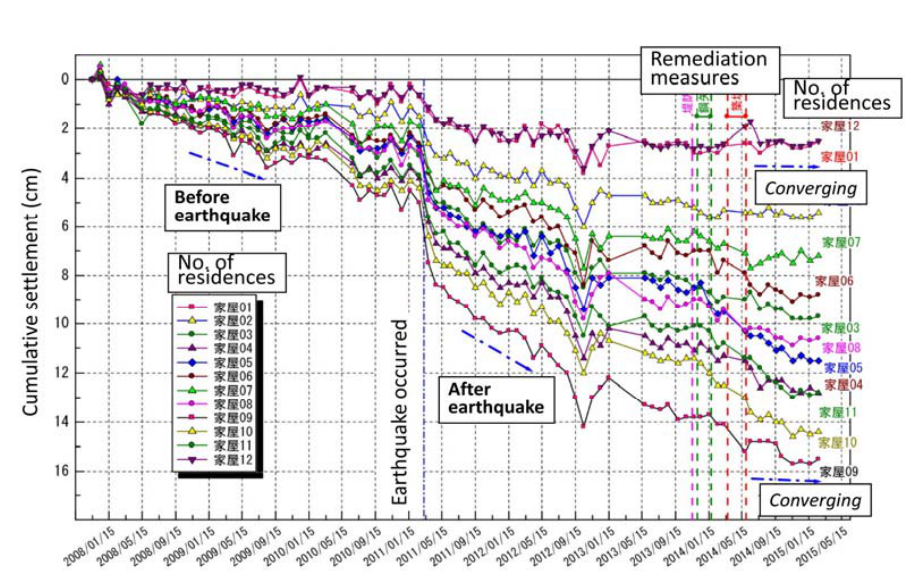
Figure 5. Settlement vs. time curves of river dykes.